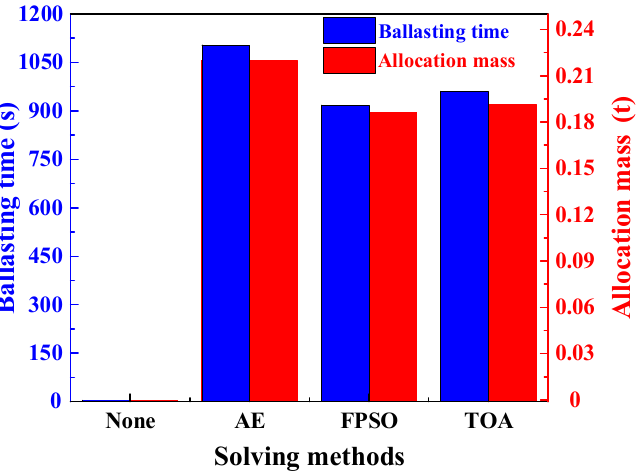
Figure 16. Total allocation mass and ballasting time for different algorithms.